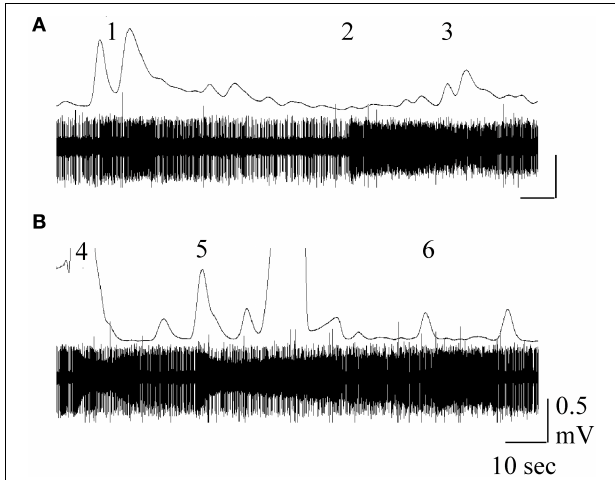
FIGURE 7 | Simultaneous GC trace (top) and single sensillum recording (bottom trace) obtained in response to stimulation with M. sexta larva-damaged tobacco ( Nicotiana attenuata , A) or D. wrightti (B). Numbers indicate neuron responses to phenol (1), 4-methyl pentanol (2), cis -3-hexanol (3), cis-3-hexenyl acetate (4), benzyl alcohol (5) and methyl-benzoate (6). For methods, see Späthe et al. (2013). Figure courtesy of Drs. S. Kesevan and S.